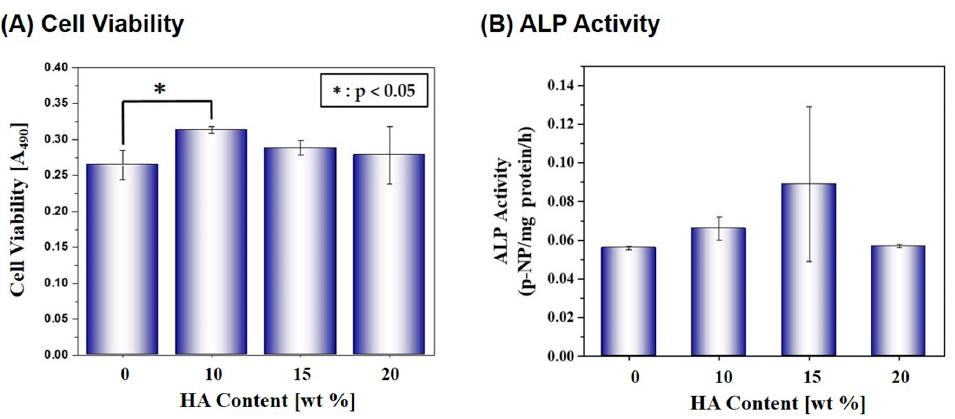
Figure 9. ( A ) Cell viability and ( B ) ALP activity of the MC3T3-E1 cells that were cultured for 5 days and 7 days, respectively, on the macro/micro-porous PCL/HA composite scaffolds (HA content = 0 wt %, 10 wt %, 15 wt %, and 20 wt %).